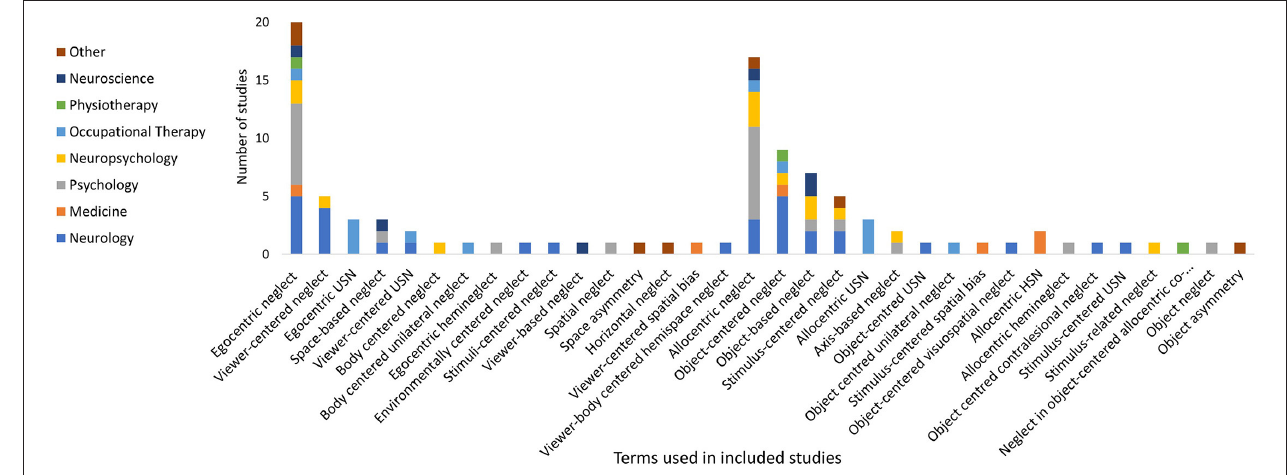
FIGURE 8 | Egocentric and allocentric neglect terms used within included studies.